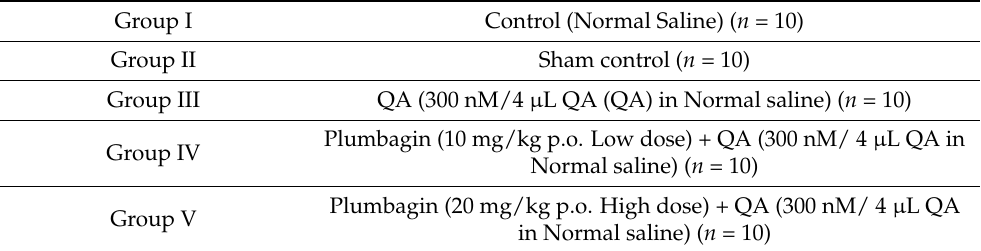
(Table 1), namely, Control (Normal Saline), sham control, QA group (300 nM/4 μ L in Nor- mal saline), low dose plumbagin group (10 mg/kg p.o.) with QA, and high dose plum- bagin group (20 mg/kg p.o.) with QA. The dose of QA and plumbagin was selected on the basis of previous experimental studies [46–48]. Table 1. Experimental grouping and dosing. Table 1. Experimental grouping and dosing .